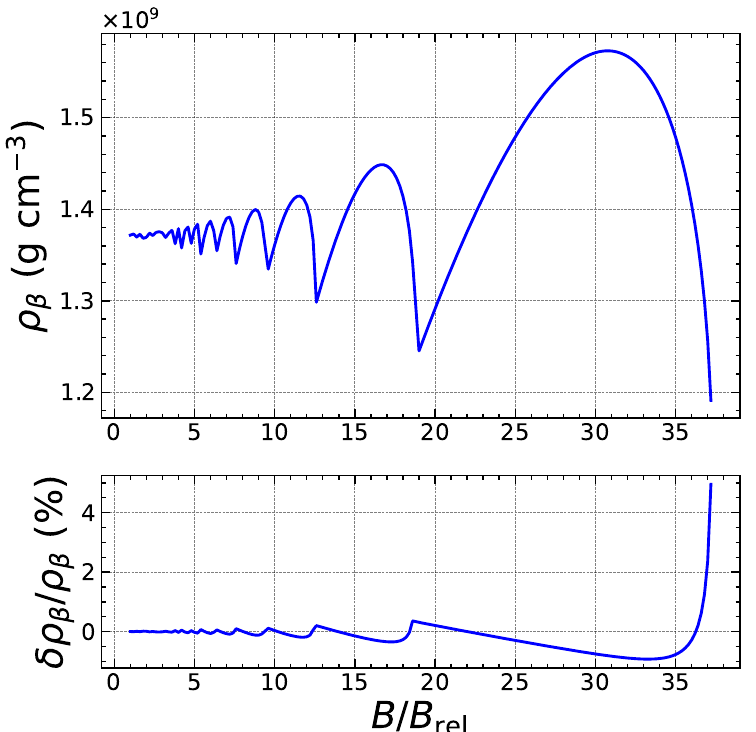
Figure 3. Top panel : Exact threshold density (in cgs units) for the onset of electron captures by 56 Fe as a function of the magnetic field strength B (cid:63) = B / B rel up to the onset of the strongly quantizing regime. Bottom panel : Relative error (in %) of the approximate analytical